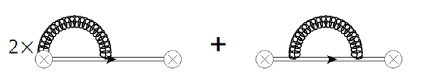
Figure 4: One-loop Feynman diagrams for Jet